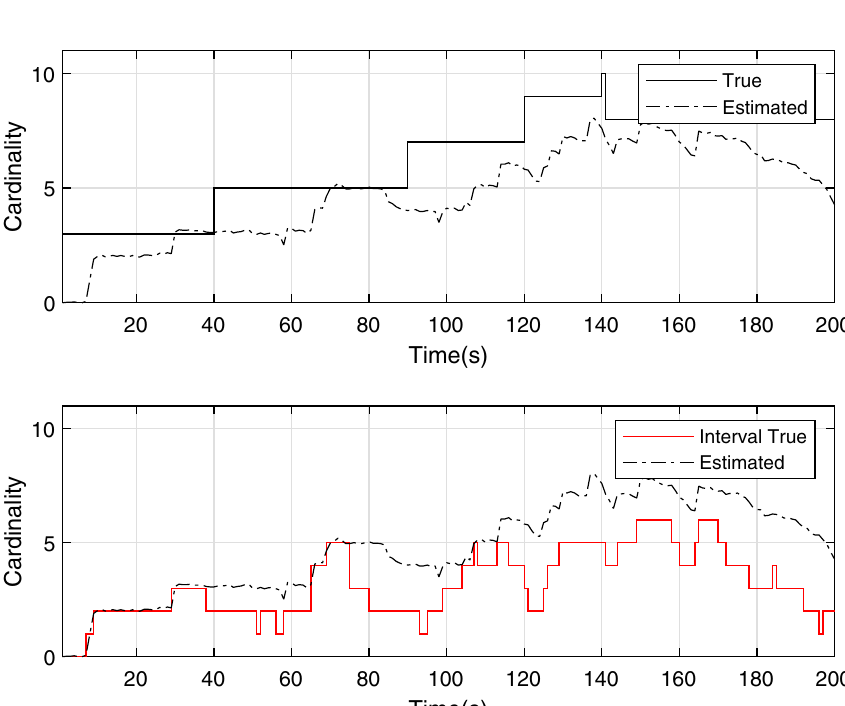
Fig. 10 The estimation of the number of